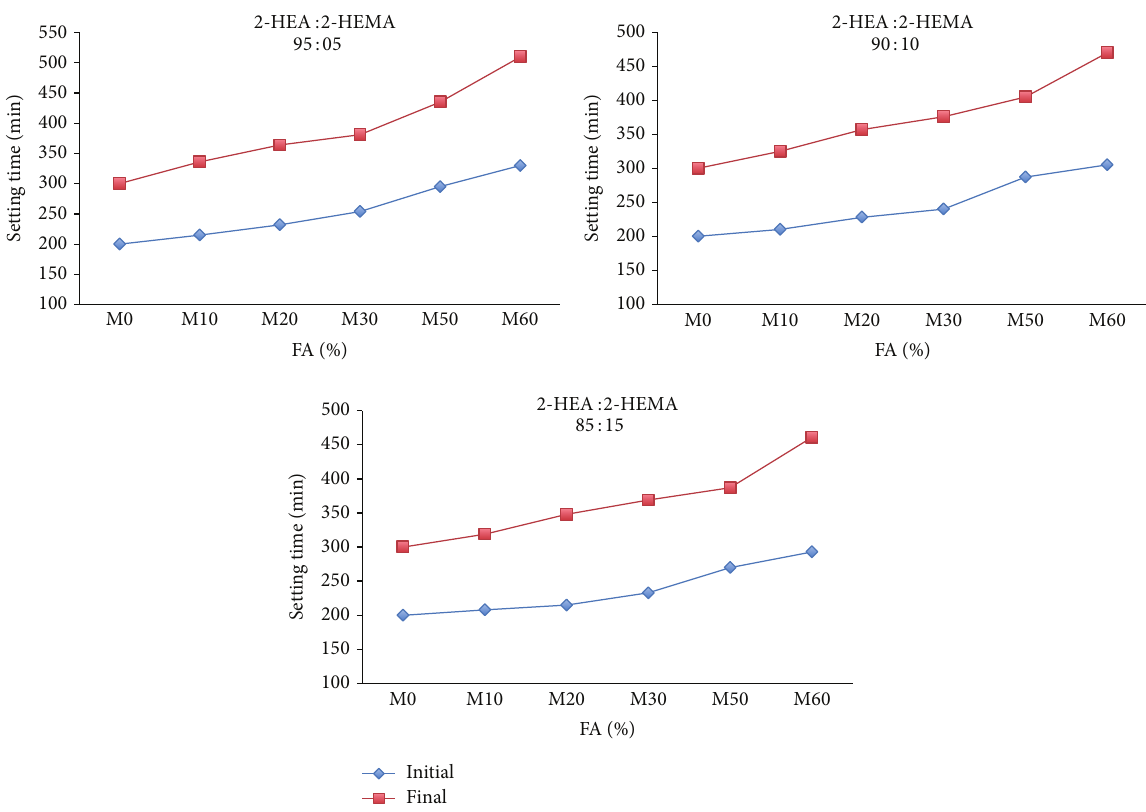
Figure 4: The effect of FA on the setting time of mortar mixes in presence of latexes.